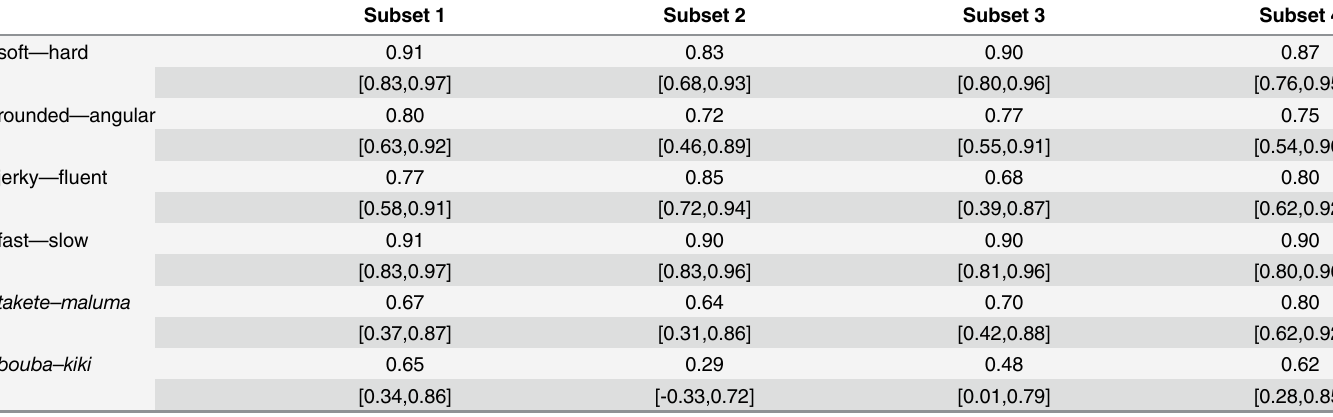
Table 1. Average Measure Intraclass Correlations for Verbal Descriptors of Body Motion and Ratings of takete - maluma and bouba - kiki .